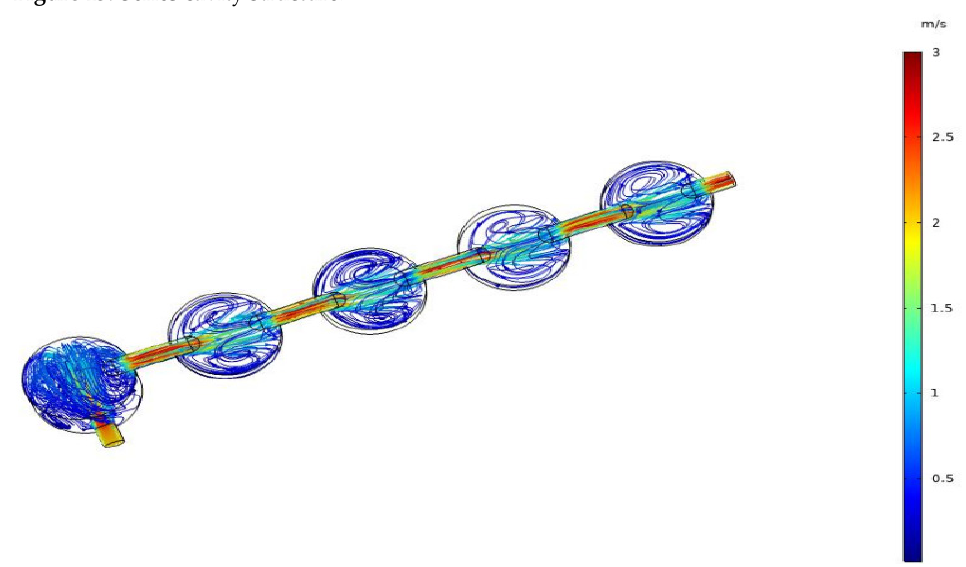
Figure 14. Simulation results of the velocity field in series cavity.